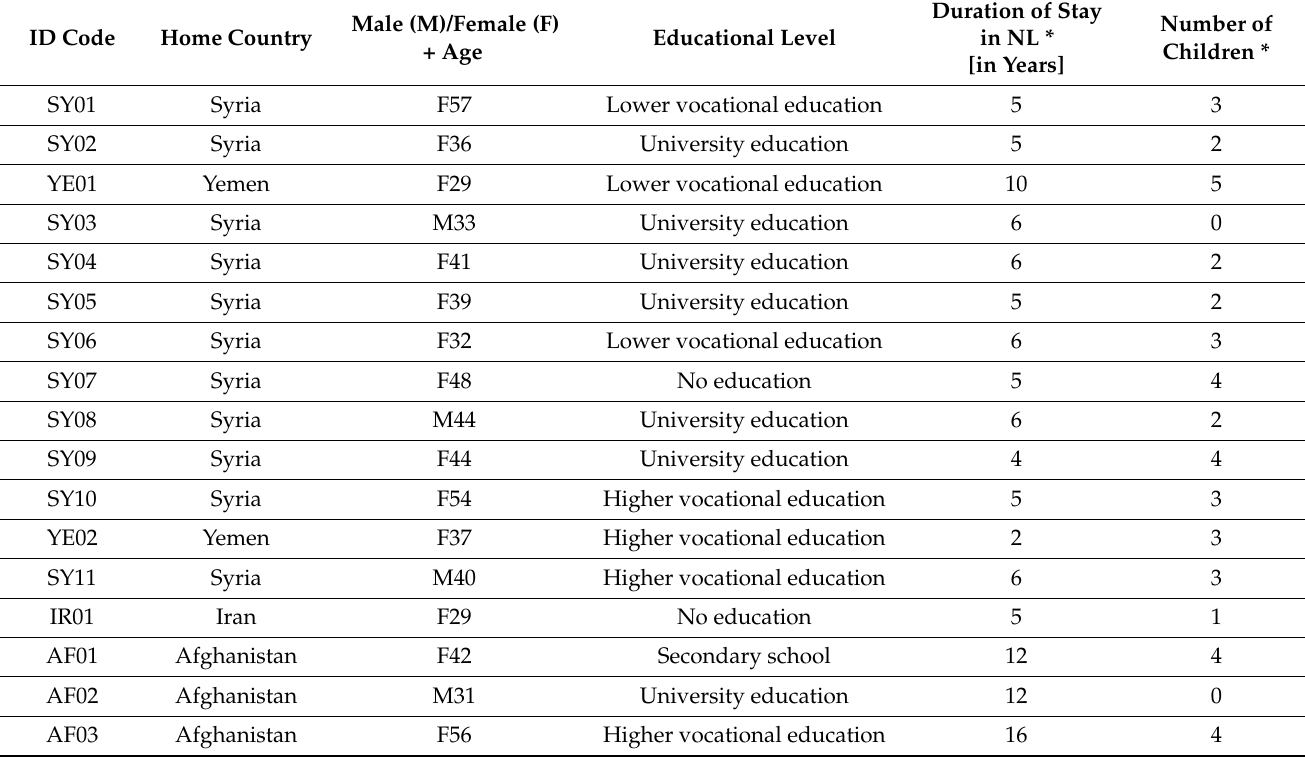
Table 1. Overview of